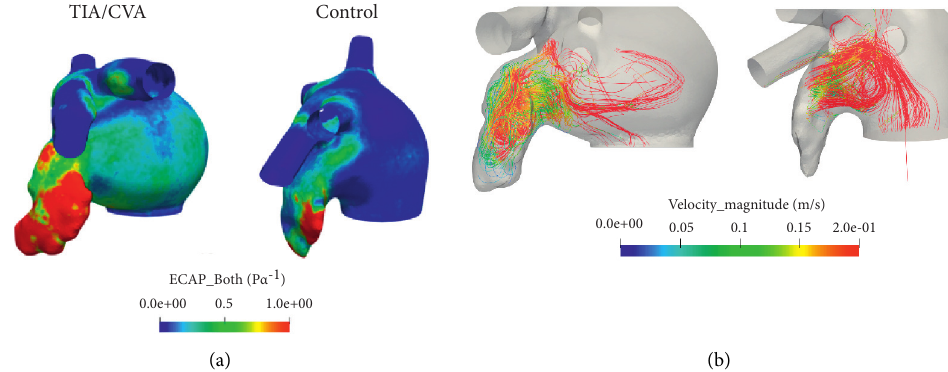
Figure 3: (a) Three-dimensional maps of endothelial cell activation potential (ECAP) for a transient ischemic attack or cerebrovascular accident patient (left) and a control case (right). High ECAP values (red areas) indicate a higher risk of thrombus formation due to low velocities and complex blood flow. (b) These velocities as well as the complexity of the flow within the LAA can be visualized with the streamlines for a thrombus case (left), while in a control case (right) flow remains in the ostium and does not reach the tip part of the Table 3: Haemodynamic indices (mean ± standard deviation) for the whole LAA in controls and TIA/CVA groups. Control TIA/CVA p value TAWSS (Pa) 0.31 ± 0.12